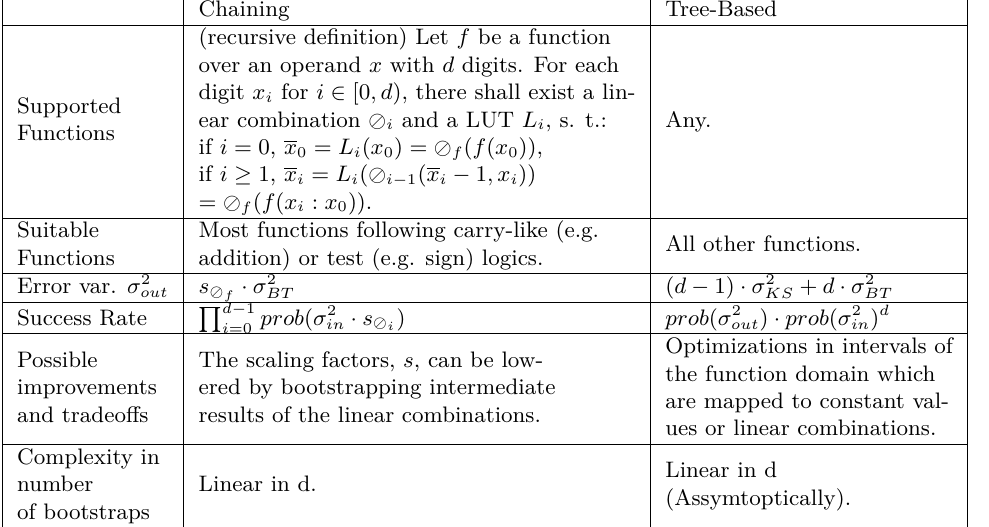
Table 1: Comparison between the chaining and tree-based methods. We use overbars to indicate output variables, (cid:11) to represent linear transforms, and “:” to denote digit slicing. The function prob is given by Equation 6, d is the number of digits, s is the scaling factor of the error variance in a linear transform (i.e. how much the linear transform increases the error variance), and σ 2 represents error variances (specifically, σ 2 output error variance of the bootstrap and TRLWE Key switching,